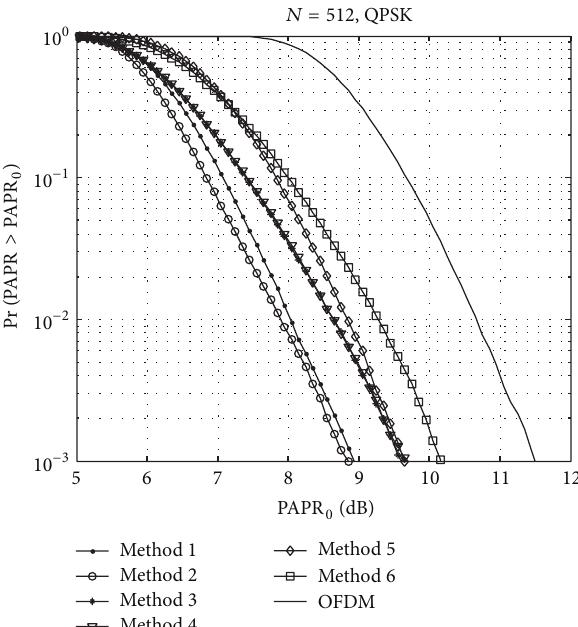
Figure 3: CCDF comparison of DSI